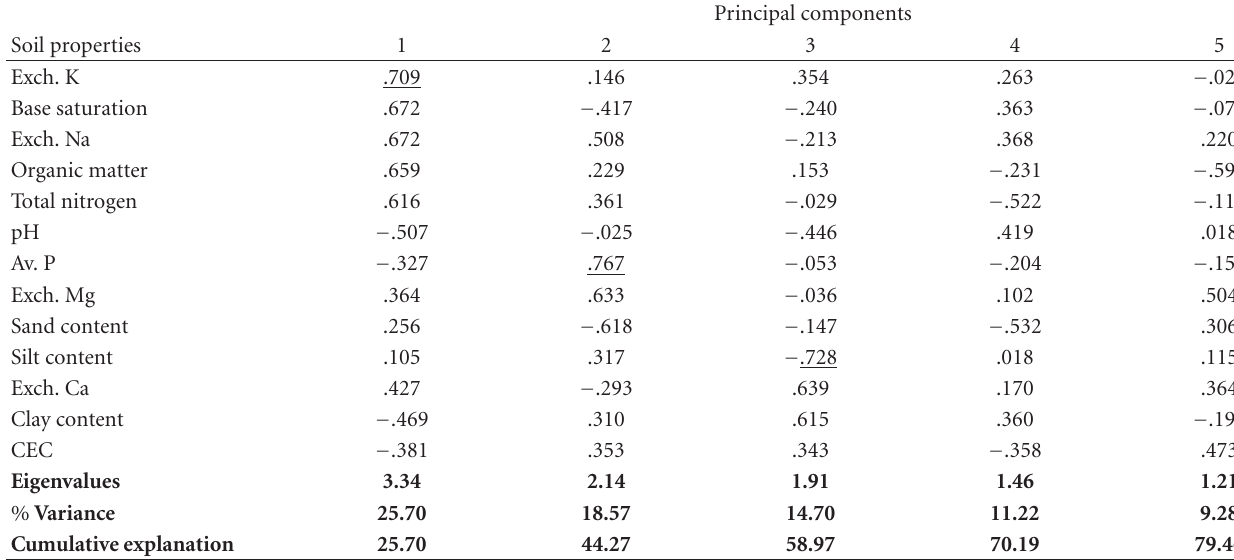
Table 3: Ordinary components matrix of soil properties a . Principal components